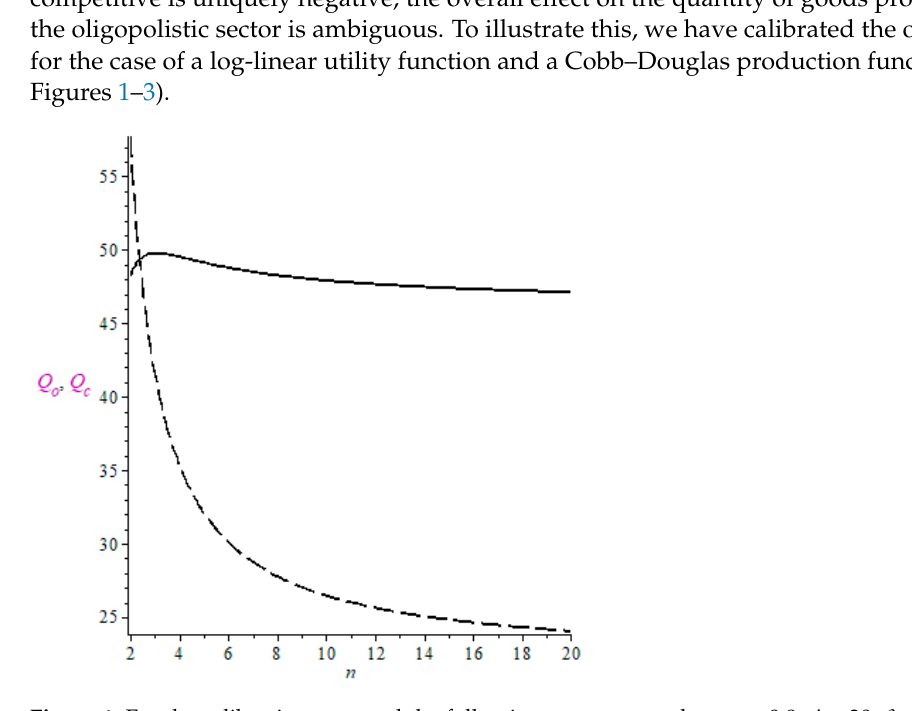
Figure 2. To calibrate Figure 2, we used the following parameter values: (cid:1869) = 0.8 , (cid:1827) = 20 , (cid:2010) = 0.09 , and (cid:2009) = 0.3 .